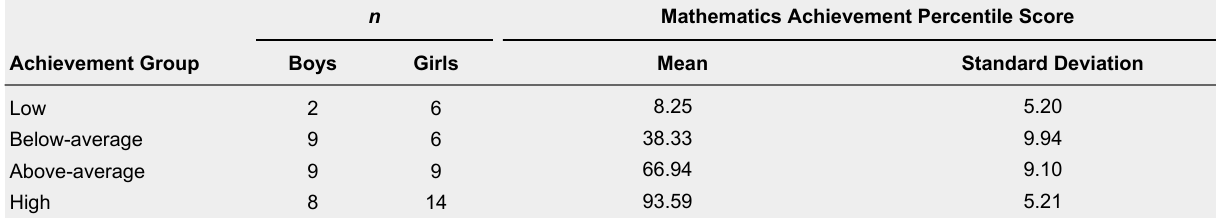
Number of Boys/Girls and Mathematics Achievement Percentile Score per Mathematical Achievement Group (n = 63) n Mathematics Achievement Percentile Score Achievement